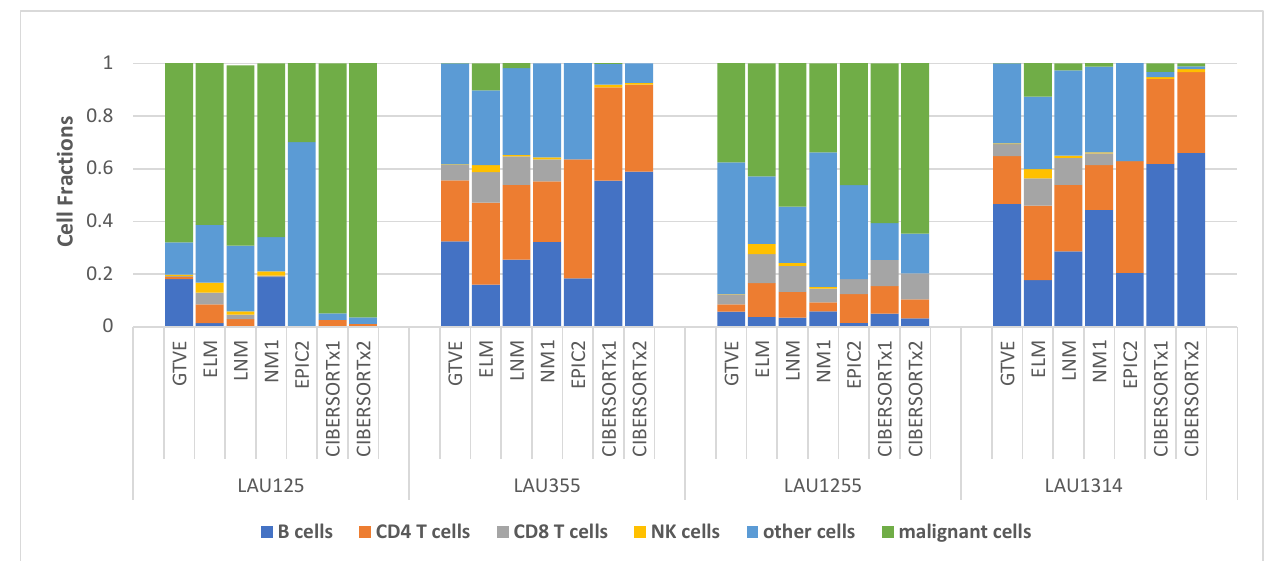
Figure 2. Stacked cell-type fractions per melanoma sample comparing results from different decon- volution methods with ground-truth experimental values.